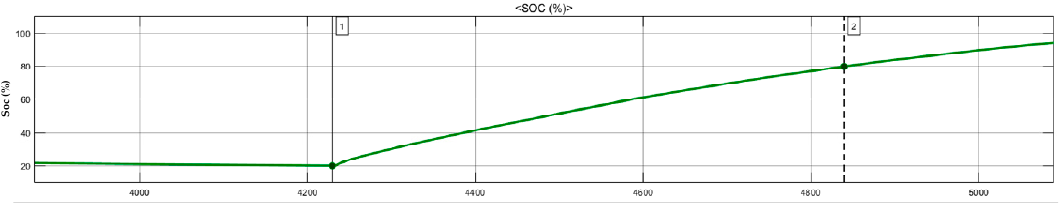
Figure 16. SOC from 20% to 80%.